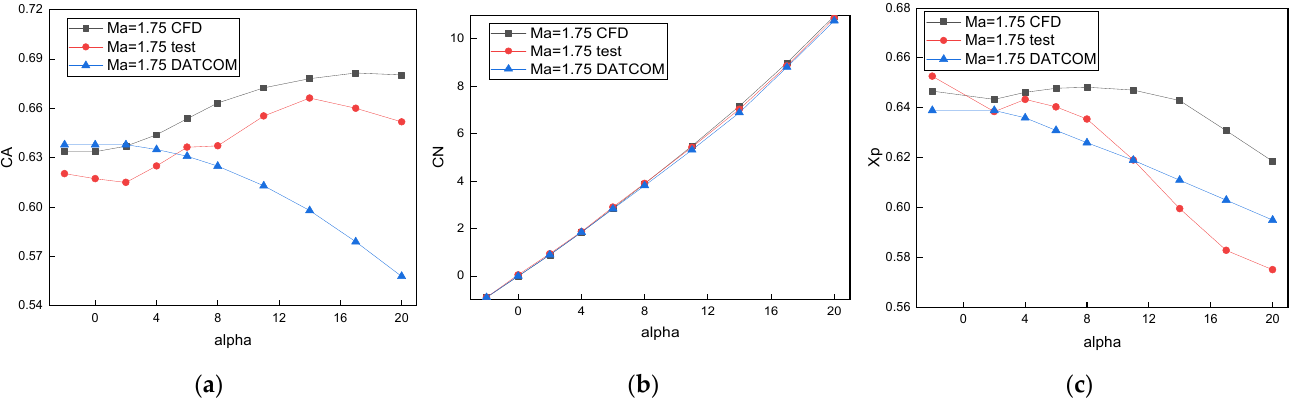
Figure 8. Aerodynamic coefficient at Ma = 1.75. ( a ) CA , ( b ) CN , and ( c ) Xp .